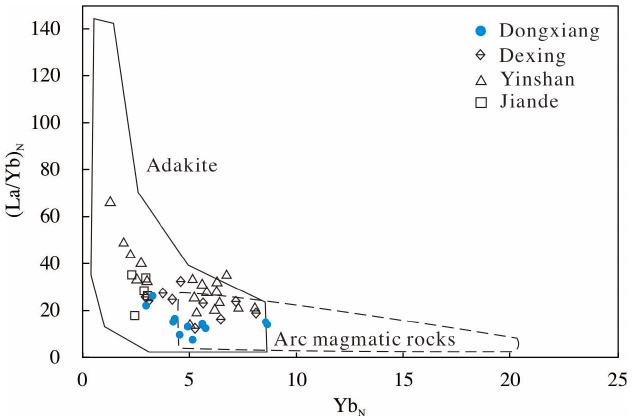
Figure 8. (La/Yb) N vs. Yb N for the Dongxiang intrusive rocks (adapted from Defant and Drummond, 1990) [52].